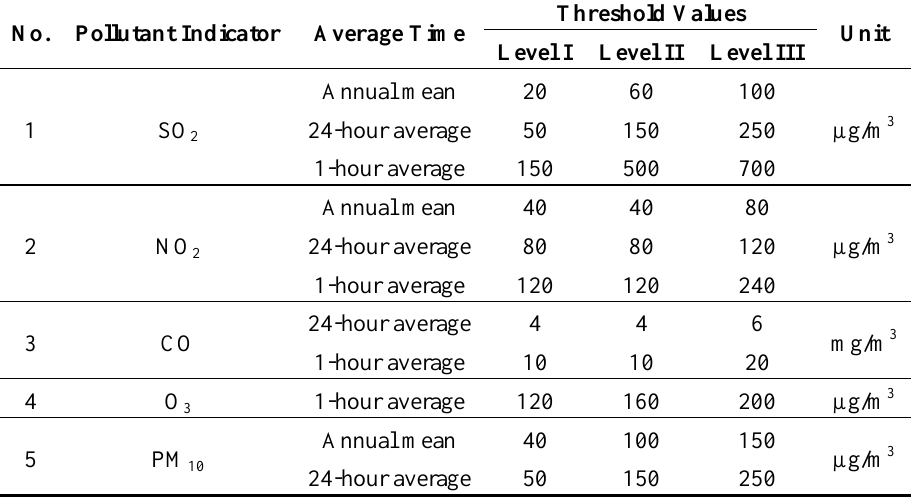
Table 1. Threshold values of ambient air pollutant indicators in GB 3095-1996. No.